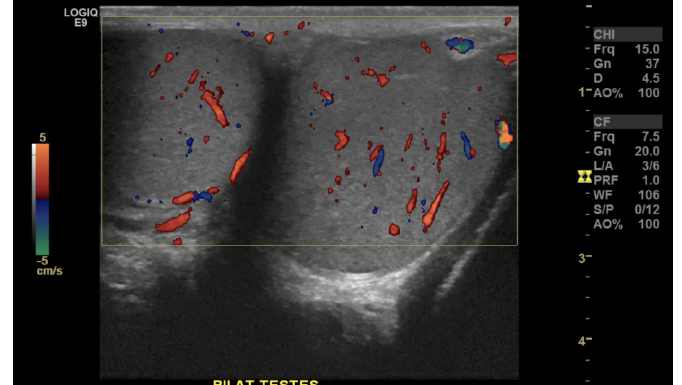
Image 1. The patient’s normal scrotal ultrasound.